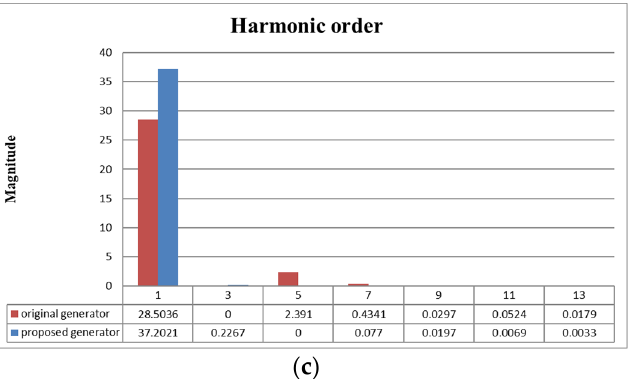
Figure 17. Voltage waveform and harmonic order; ( a ) original generator, ( b ) proposed generator, ( c ) harmonic order of original and proposed generators.